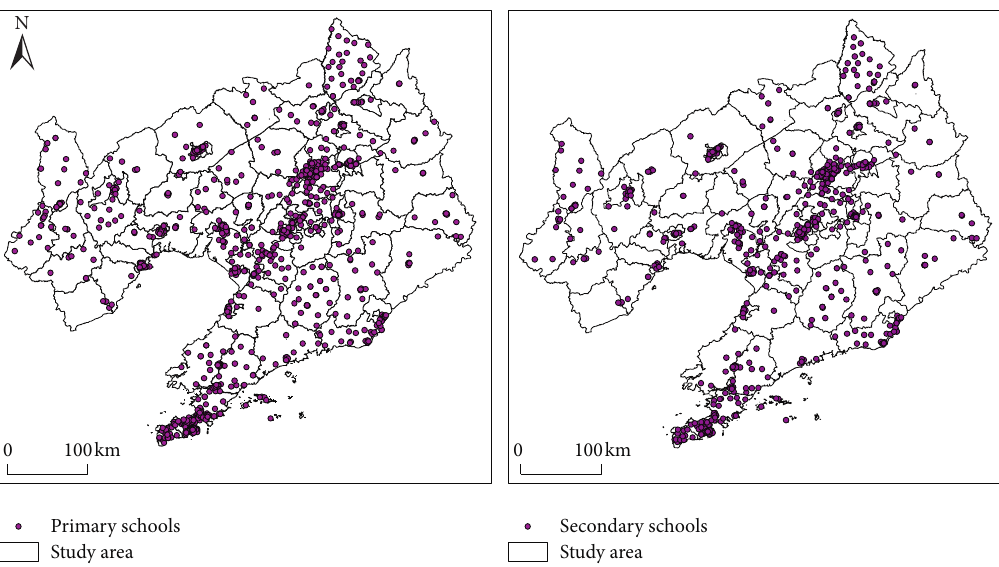
Figure 2: Sample points of primary and secondary schools for relocated children of migrant workers. Table 1: Data sources and